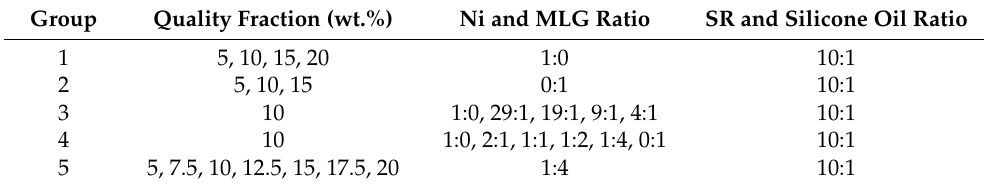
Table 1. Sensing unit preparation sample parameters.